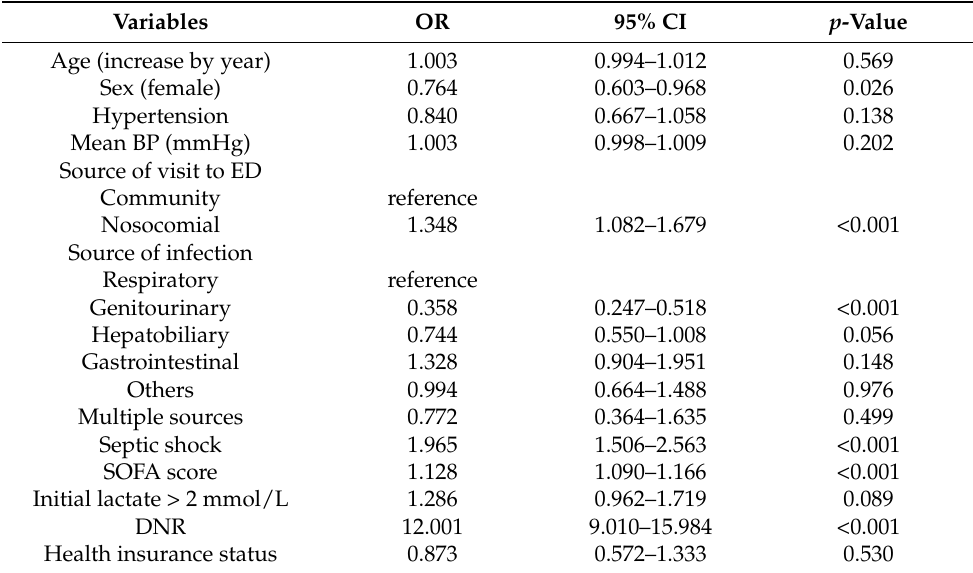
Table 4. Multivariate logistic regression analyses for in-hospital